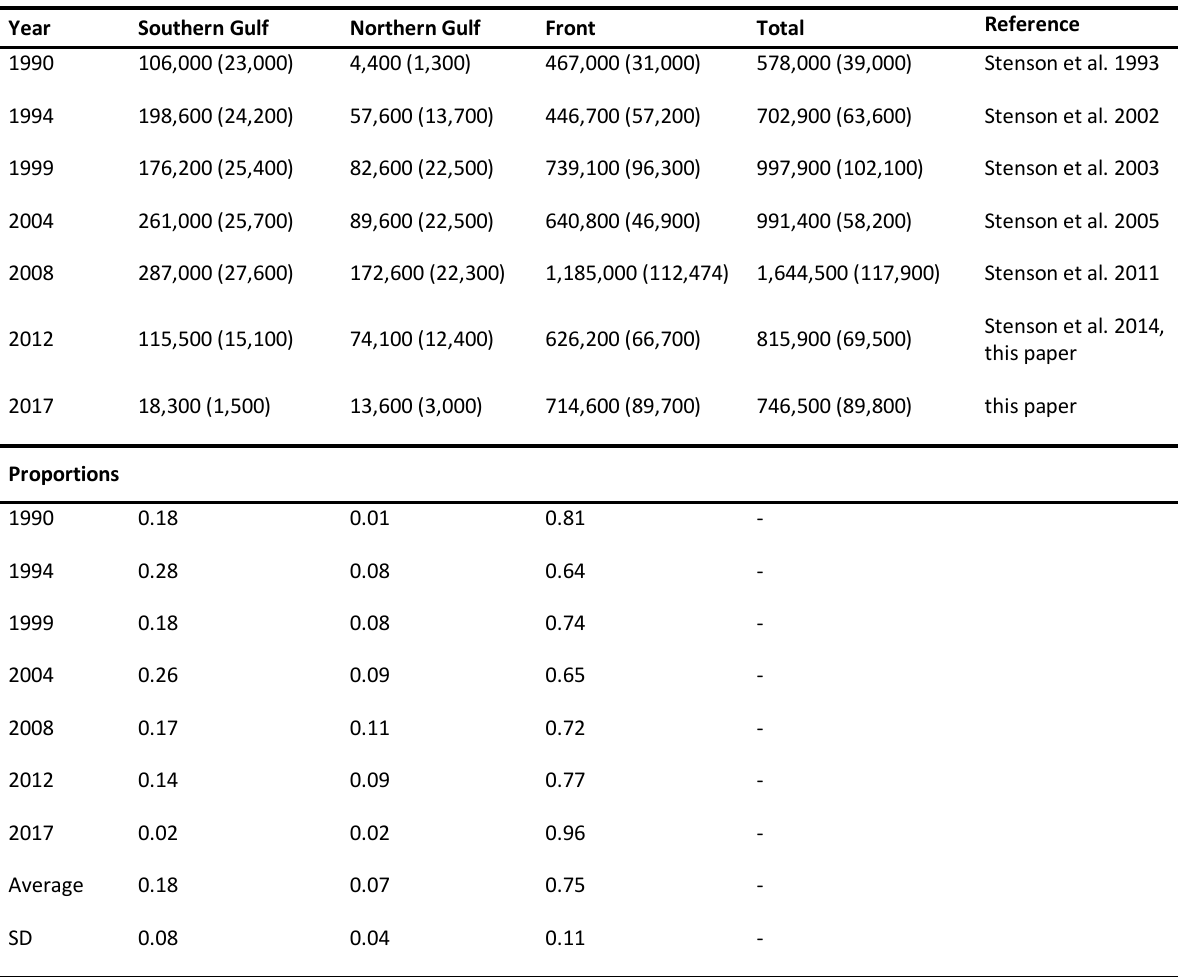
Table 4. Northwest Atlantic Harp Seal pup production estimates from aerial surveys completed since 1990 (with SE), and the proportion of pupping in each